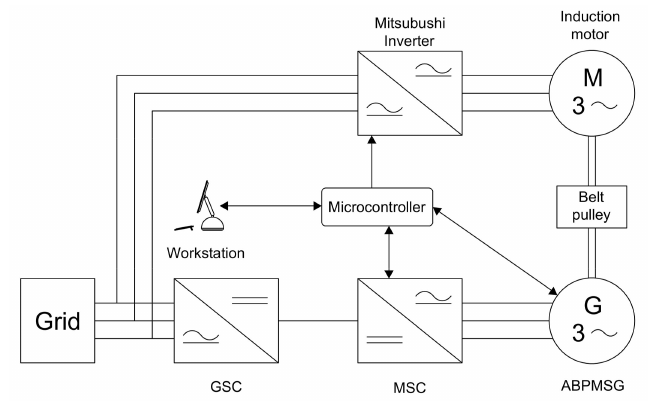
Figure 11. The test rig’s logical scheme.